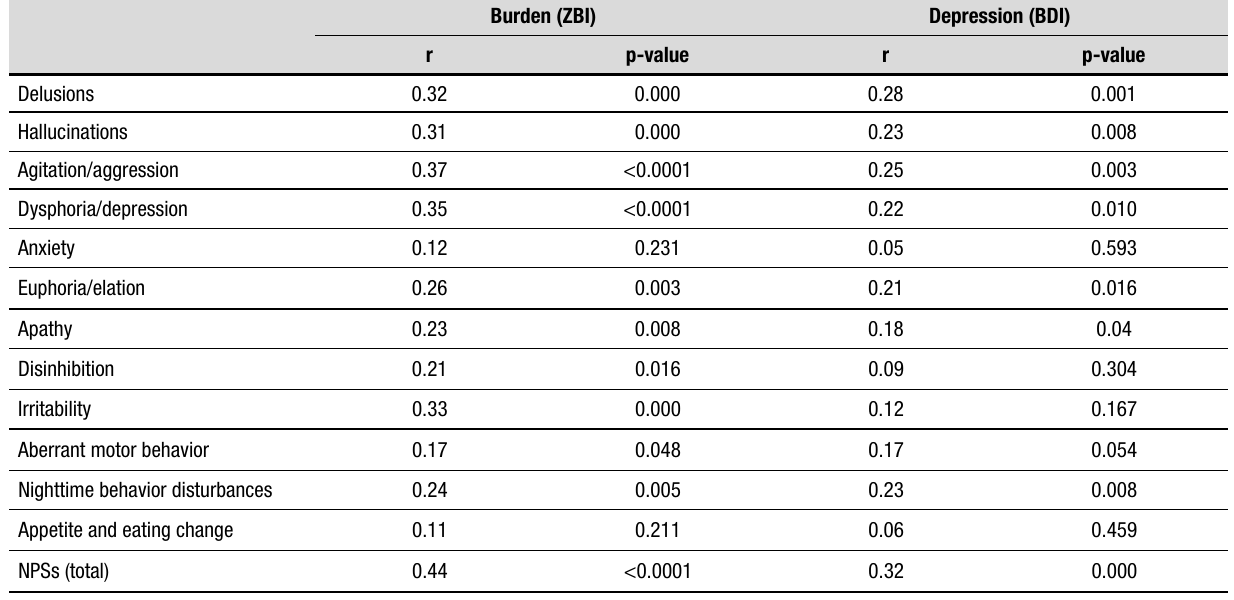
Table 4. Correlations between neuropsychiatric symptoms of people with Alzheimer’s disease and caregiver burden and